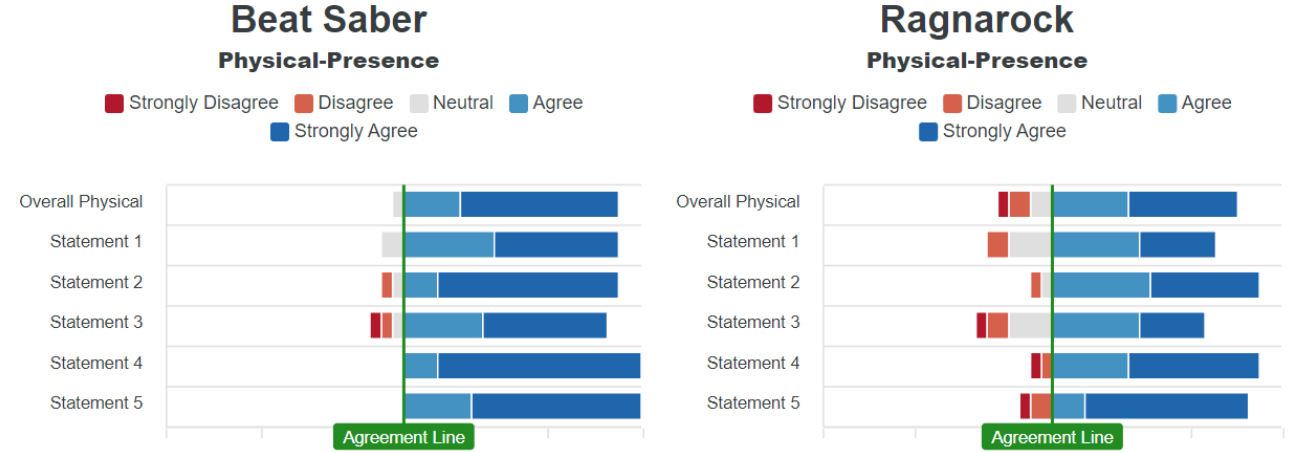
Figure 2. Comparison between physical presence ratings for Beat Saber and Ragnarock. This shows very high results for physical presence in both titles. Additionally, Beat Saber scored significantly higher in the overall Physical sub-scale, as well as statements 1 (“The virtual environment seemed real to me”) and 4 (“While I was in the virtual environment, I had a sense of ‘being